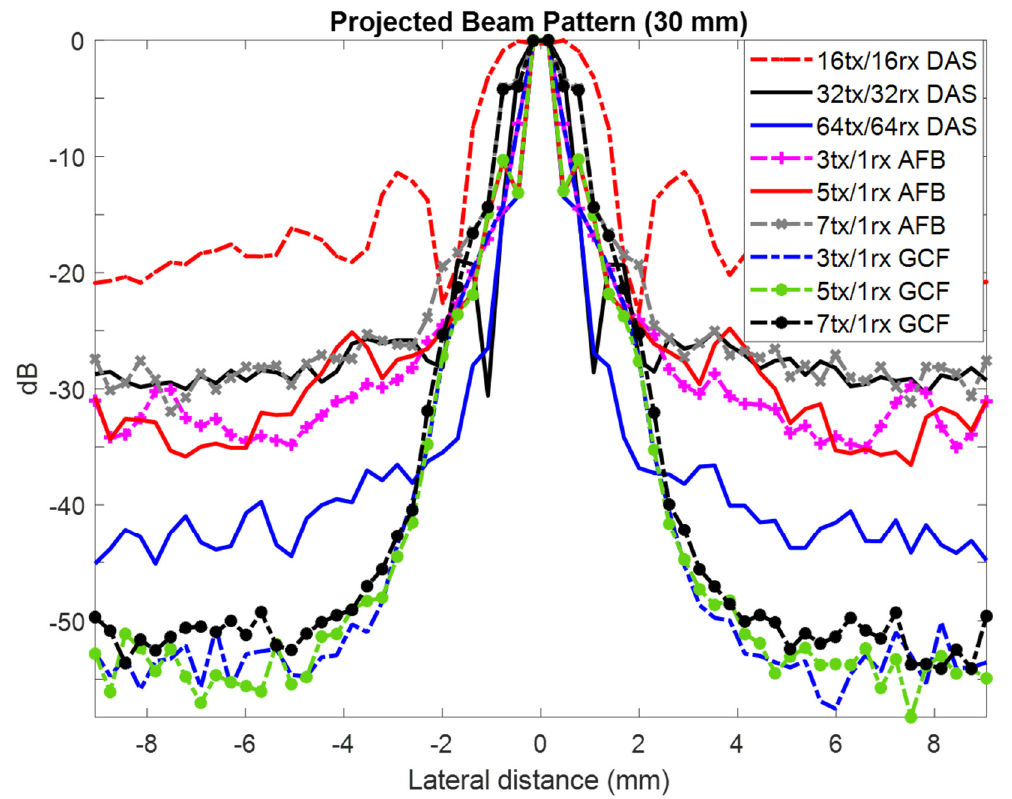
Figure 5. Beam profile in the lateral direction at the third point depth zone in Figure 4. Table 1. Comparison of the beam widths at the − 6-dB level of the lateral profile of projections representing the lateral spatial resolution and SNR at the five-point depth zones, as shown in Figure 4.